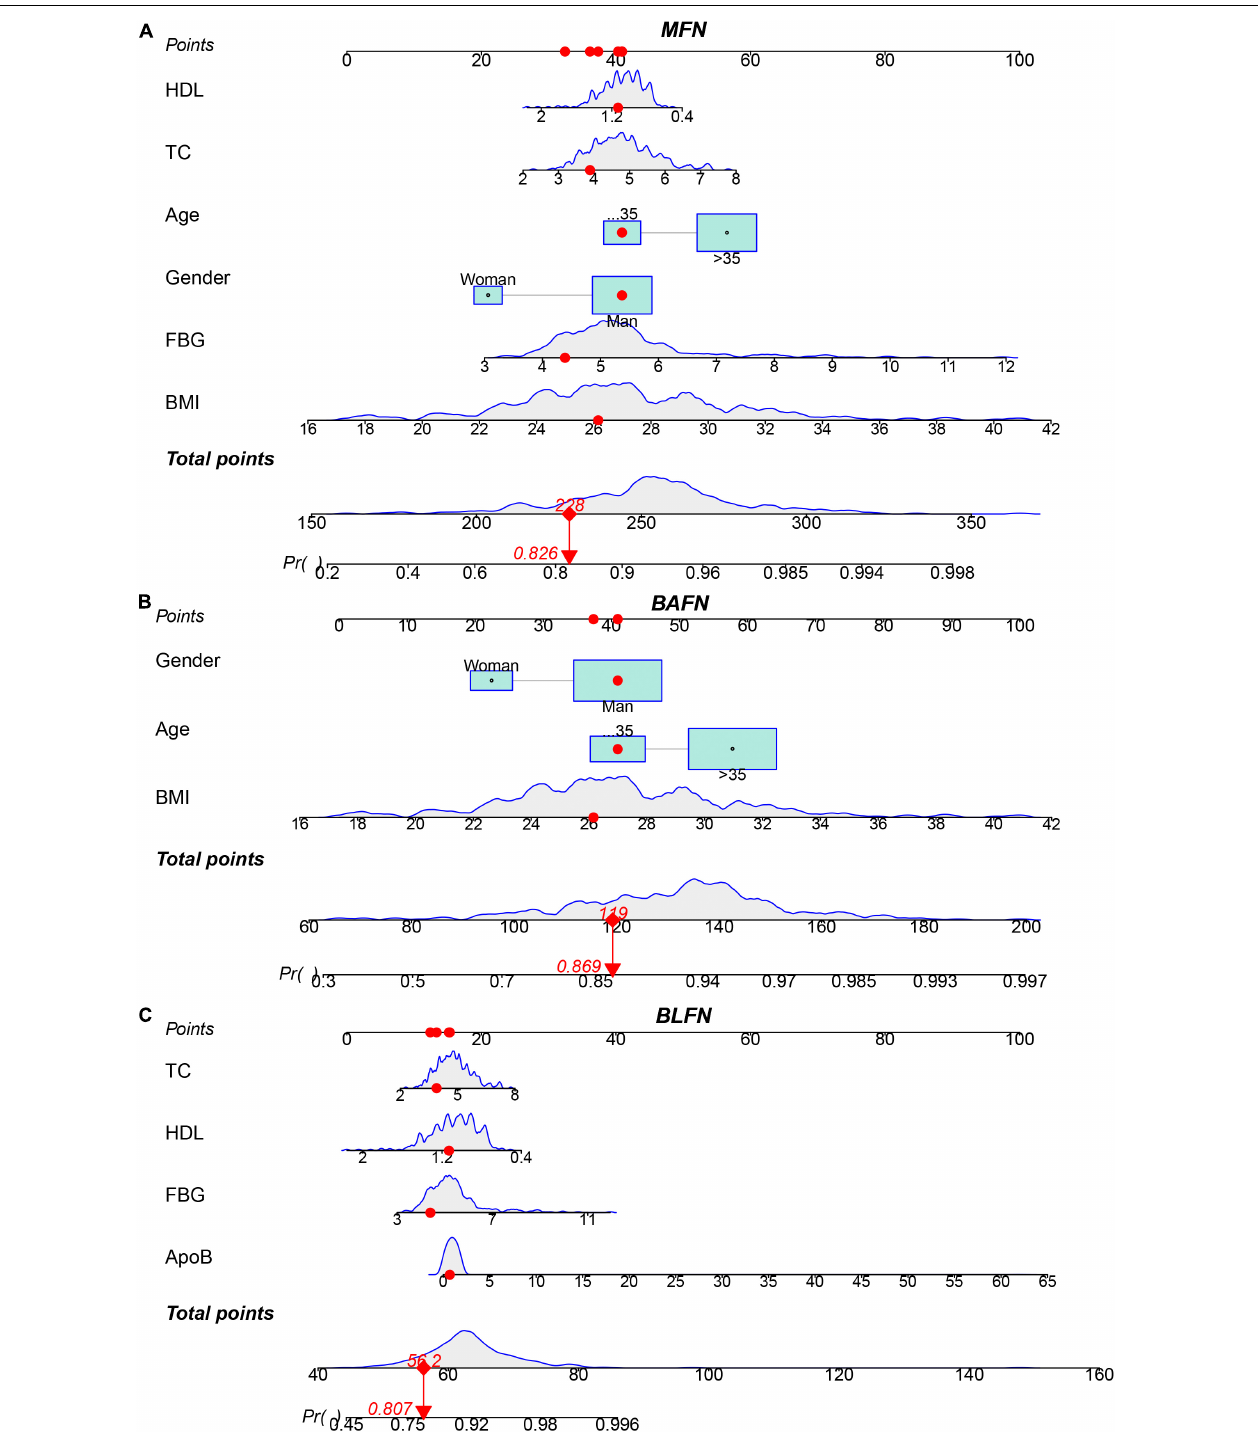
FIGURE 5 | Three types of factors screened by lasso regression were used to construct MFN, BAFN and BLFN, respectively. (A) MFN. (B) BAFN. (C) BLFN.